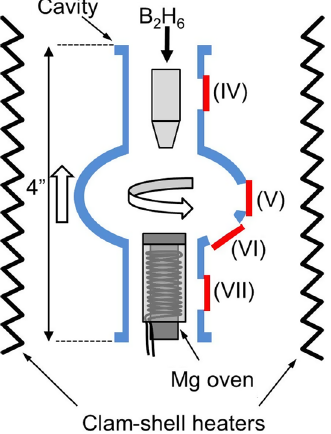
FIG. 8 (color online). Schematic view of the setup used for the dummy cavity with the (IV) top, (V) equator, (VI) curved, and (VII) bottom sample locations.